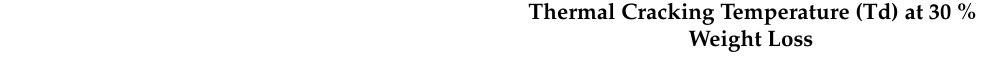
Figure 10. TGA profile of sodium alginate, chitosan, and calcium alginate composite microspheres . Table 4. Thermal cracking temperature (Td) of TGA spectrum.